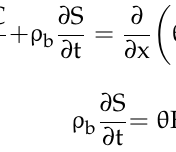
Figure 3. EDS mapping of BC-nZVI depicted that C, O, and Fe were the most plentiful components on the surface of biochar. The presence of distributed Fe confirmed a proper nZVI modification of biochar. The BET surface area analysis showed that the surface area drastically reduced from 400 m 2 /g to 23.94 m 2 /g after the modification of biochar to BC-nZVI. This is attributable to filtering out fine particles during the modification process and the occupancies of biochar pores by nZVI particles after modification, as seen from SEM-EDS analysis. The FTIR spectrum confirmed the presence of abundant functionals groups on biochar and BC- nZVI surfaces shown in Figure 4. The spectra of biochar proved the presence of carbon and oxygen functional groups such as –OH (at 3405 cm − 1 ), aliphatic (2920 cm − 1 ), C=O (1617 cm − 1 ), aromatic ring (1384 cm − 1 ), and etheric C–O–C group (1088 cm − 1 ) [48]. Spectra of BC- nZVI retained similar carboxyl and hydroxyl functional groups similarly to biochar, but